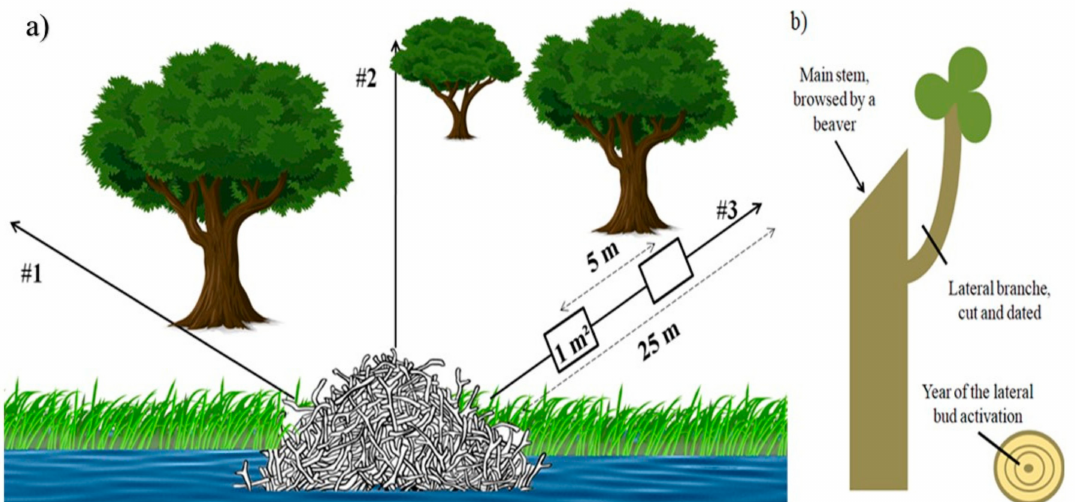
Figure 2. Sampling design. ( a ) Spatial distribution and location of transects and square plots around each beaver lodge, where squares represent the sampled plots and the bold arrows represent the three transects; ( b ) Representation of the dendroecological method used to sample and date stems browsed by